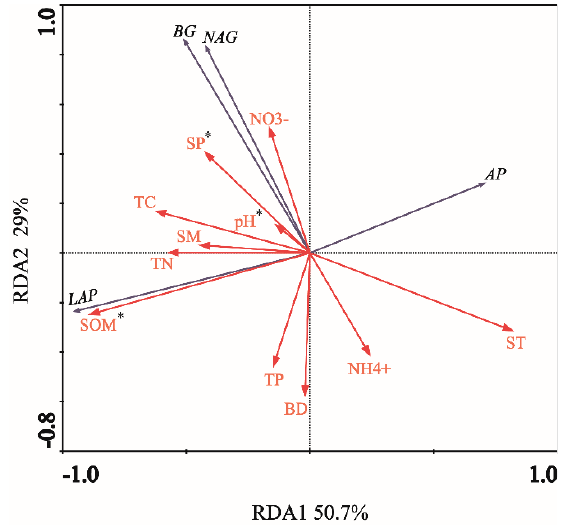
Figure 5. Redundancy analysis (RDA) of soil extracellular enzyme activities and soil factors. SM, soil moisture; BD, soil bulk density; SP, soil porosity; ST, Soil temperature; SOM, soil organic matter; TC, soil total carbon; TN, soil total nitrogen; TP, soil total phosphorus. BG, β – glucosidase; LAP, leucine aminopeptidase; AP, acid phosphatase; NAG, β – 1,4 – N – acetylglucosaminidase. * p < 0.05. Table 5. Spearman correlation coefficients between soil extracellular enzyme activities and soil